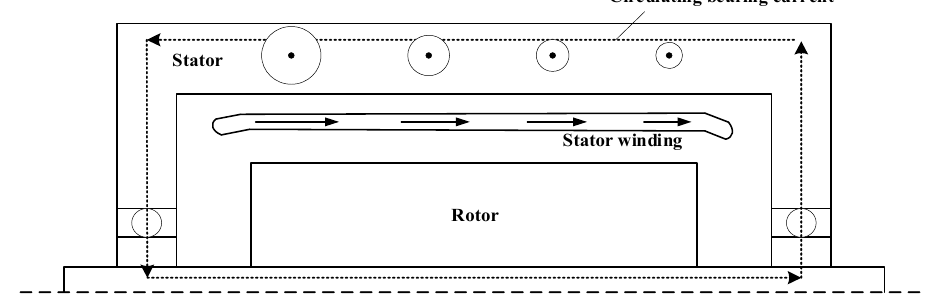
Figure 13. Circulating current due to magnetic flux asymmetry [117].